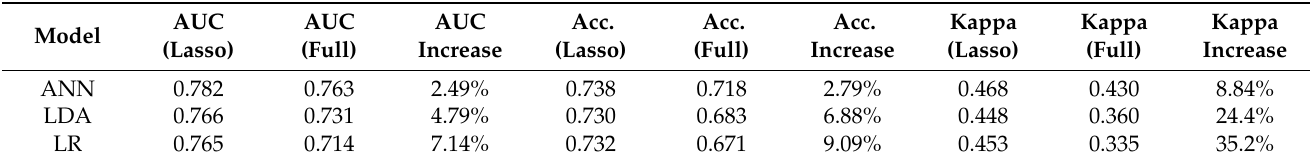
Table 6. Results of the best performing models trained on the full dataset compared to the results of a model trained on the dataset with only 8 input variables (LASSO).